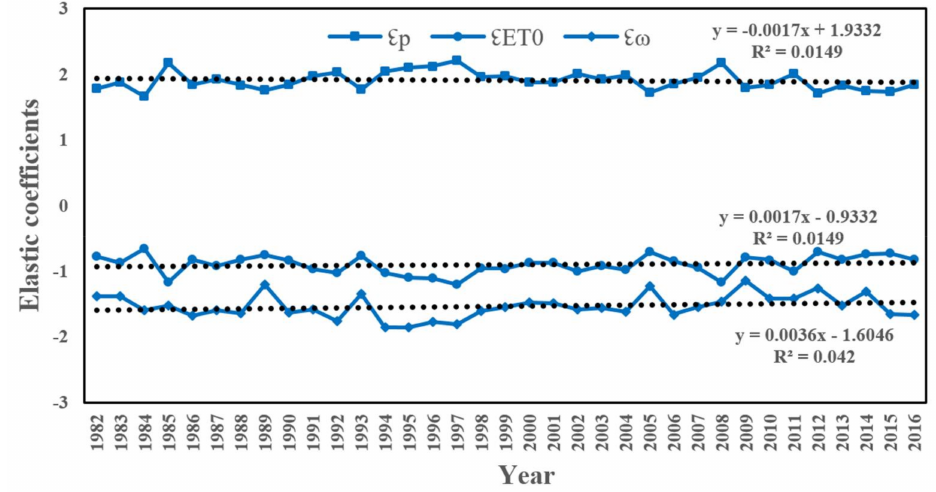
Figure 6. Change trend of precipitation elasticity, potential evapotranspiration elasticity, and under- lying surface parameter elasticity of runoff in the SAYR from 1982–2016.